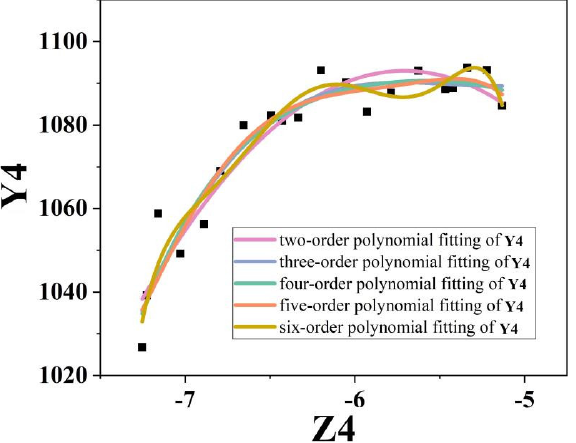
Figure 5. Five different polynomial fitting curves for RPM (Z) and EGT4(Y4).